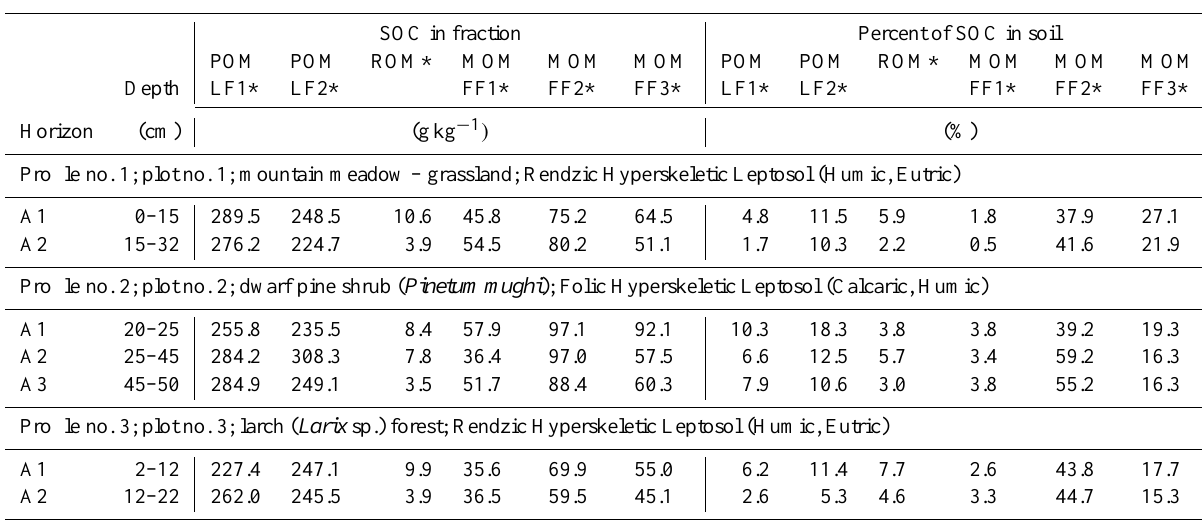
Table 4. Soil organic carbon (SOC) in